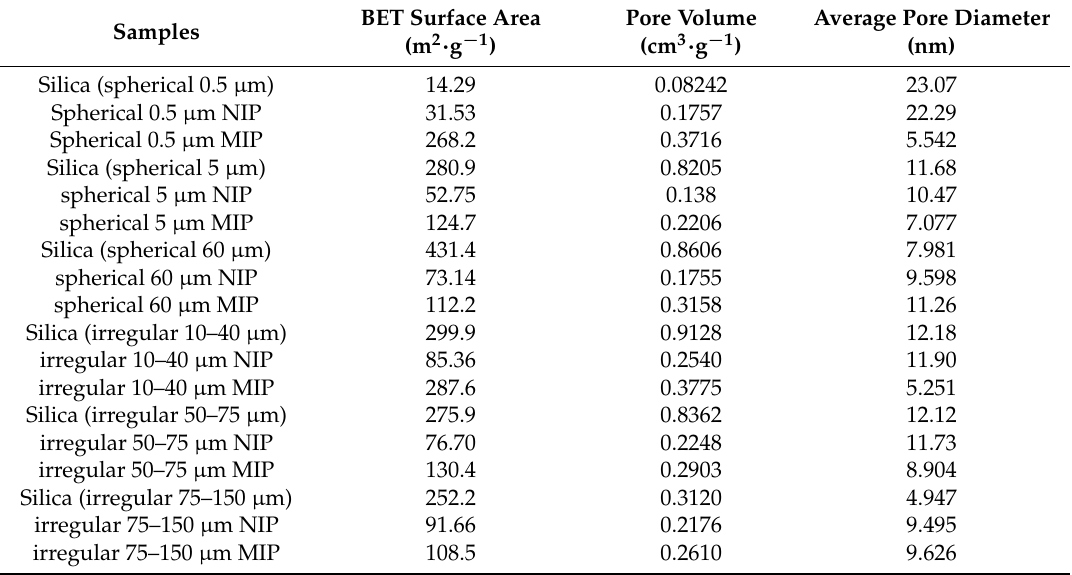
Figure 4. SEM images of silica support and its corresponding NIP and MIP ( a ) irregular 10–40 µ m silica, ( b ) irregular 10–40 µ m silica-NIP and ( c ) irregular 10–40 µ m silica-MIP; ( d ) irregular 50–75 µ m silica, ( e ) irregular 50–75 µ m silica-NIP and ( f ) irregular 50–75 µ m silica-MIP; ( g ) irregular 75–150 µ m silica, ( h ) irregular 75–150 µ m silica-NIP and ( i ) irregular 75–150 µ m silica-MIP. Table 1. BET surface area, pore volume and average pore diameter of six silica gel supports and their corresponding MIPs and